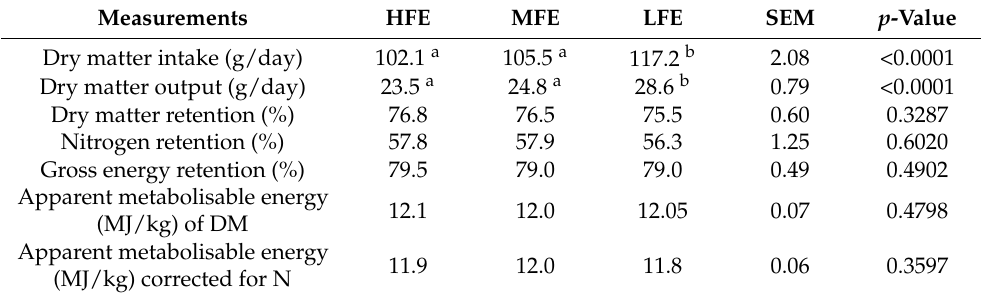
Table 4. Apparent metabolisable energy (AME), nitrogen retention and digestibility rate of individual ISA Brown hens in the mid stages of lay, based on differences in their FE. ( n = 20 per FE group).